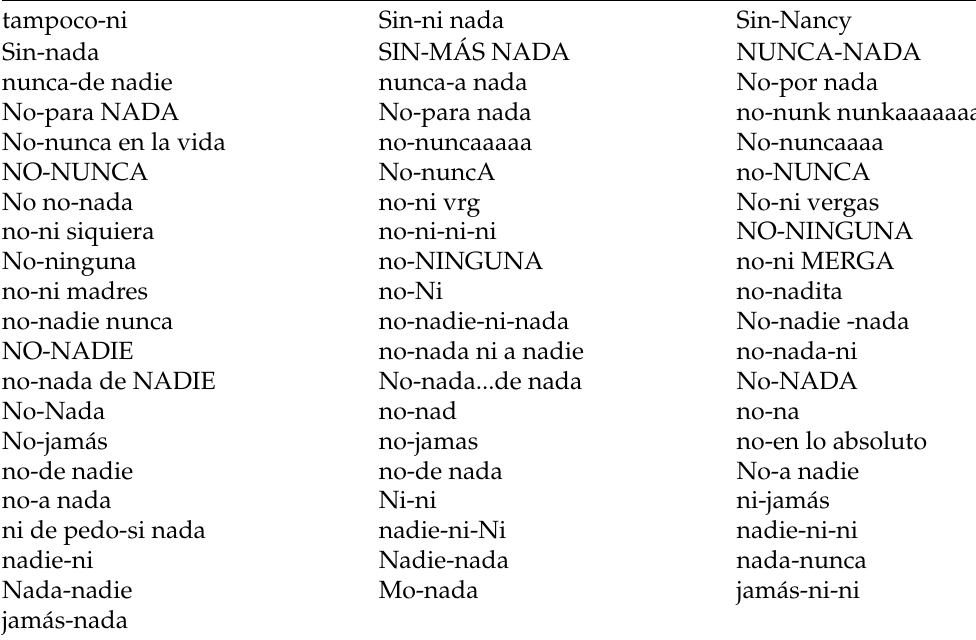
Table A4. Related negation cues with one occurrence.